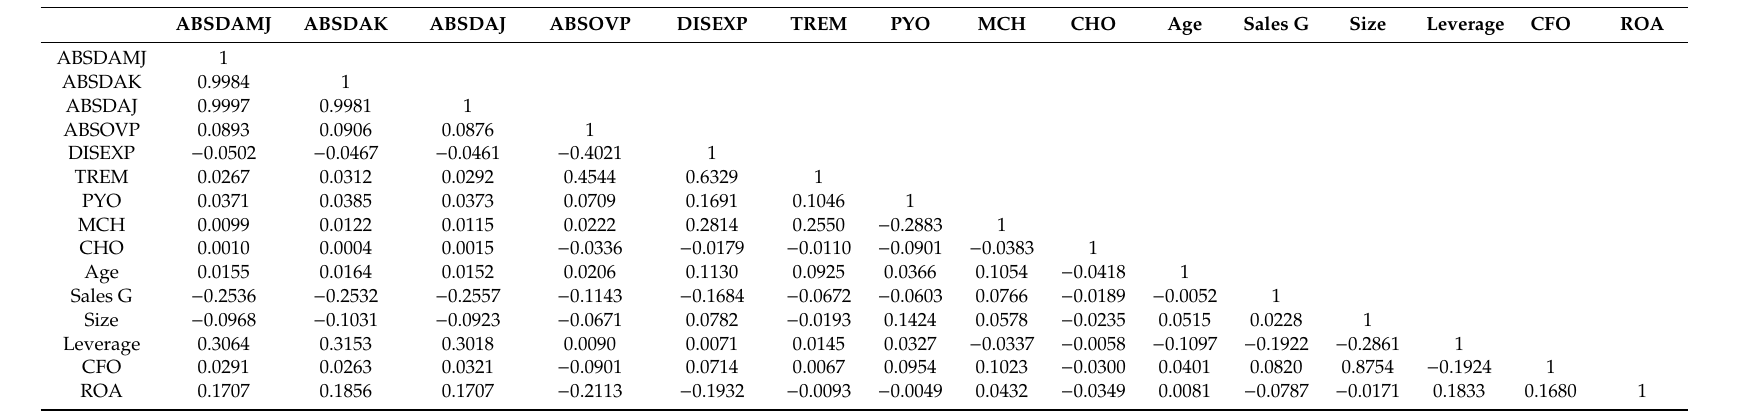
Table 3. Correlation